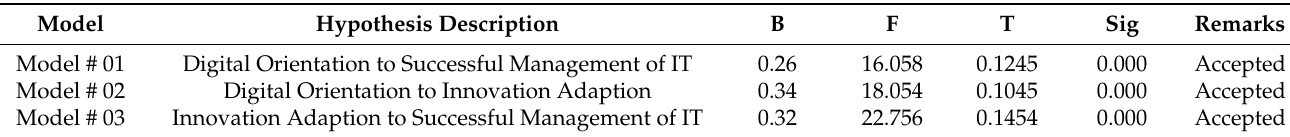
Table 4. Hypothesis Testing (H1,H2,and